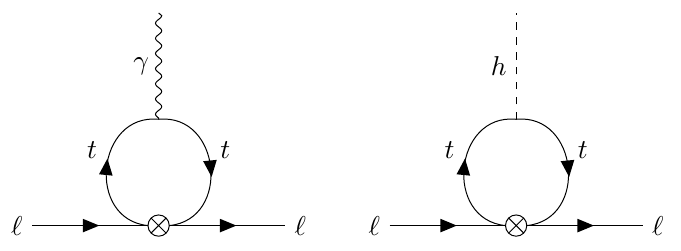
Figure 2 . One-loop diagrams appearing in the EW matching of O 5 ,‘ to Q 2 ,‘ (left, details